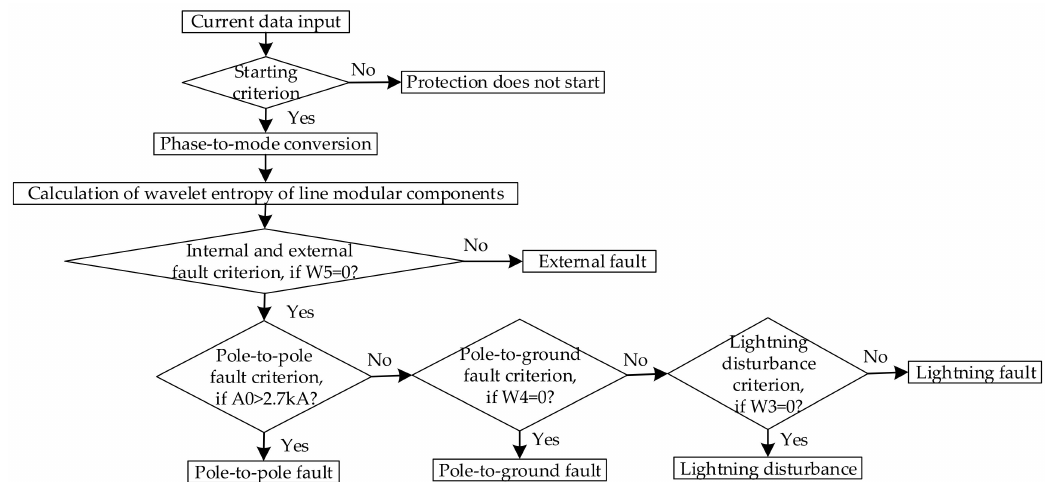
Figure 15. Flowchart of the protection plan.